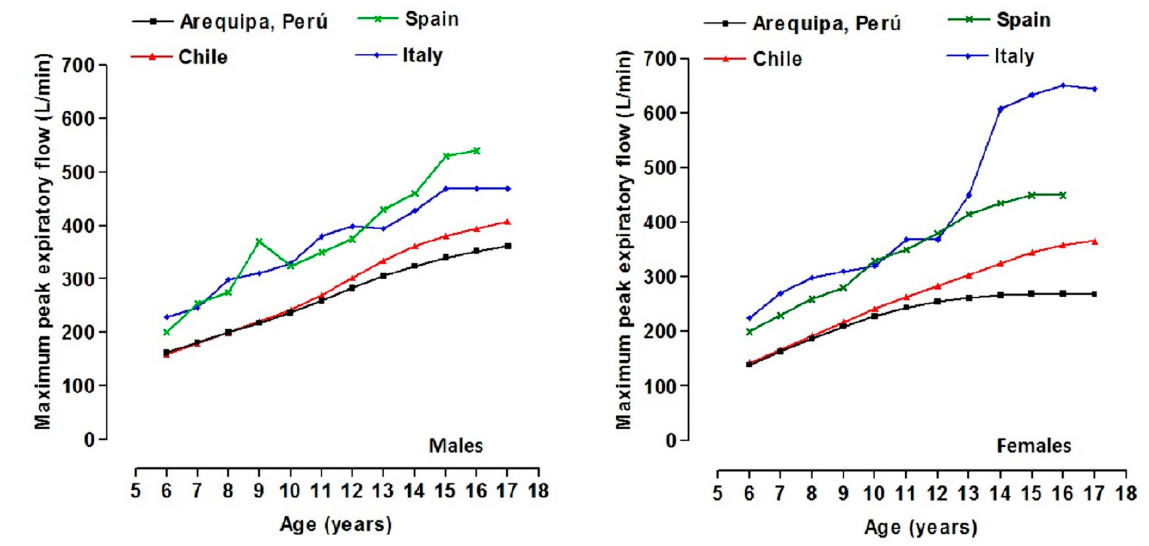
Figure 1. Comparison of the MEF by age and sex with international references for Spain [6], Italy [7], and Chile [8]. The MEF values are arranged by chronological age (years) and maturation (APHV) in Figure 2. Correlations between chronological age and MEF for males was from (r = 0.68, R 2 = 0.39), and for females, it was from (r = 0.46, R 2 = 0.21). Correlations for males for the state of maturity (APHV) and MEF were from (r = 0.66, R 2 = 0.44), and for females, they were from (r = 0.51, R 2 = 0.26). In all cases, the significant values were ( p < 0.05).